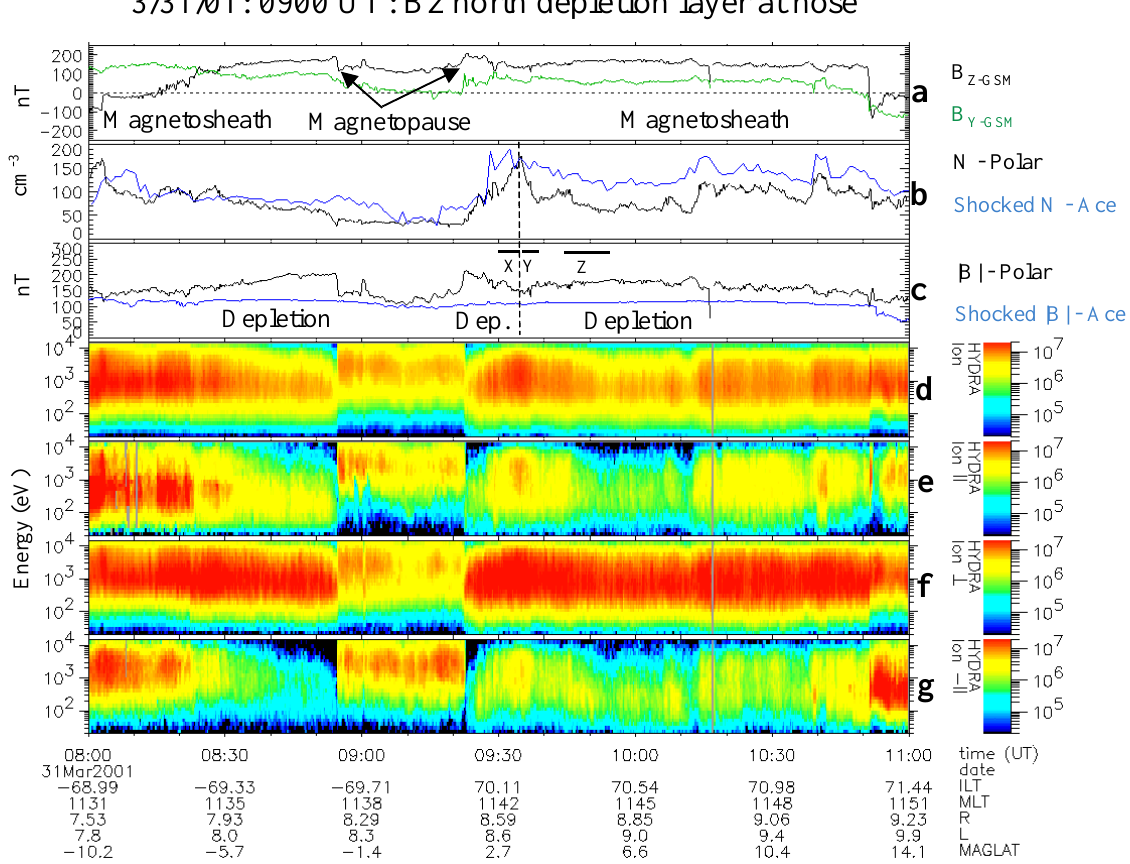
Fig. 1. Example from Polar of depletions layers with IMF B Z northward. Polar was located at 0 ◦ MLAT and 11:40 MLT. (a) The black trace is the measured B Z at Polar. The green trace is the measured B Y . The larger value of B Z just outside the magnetopause is a signature of a depletion layer. (b) The measured ion density at Polar (black) compared to the properly lagged (38min) ion density measured at ACE upstream in the solar wind (blue). Plasma densities attributed to ACE have been multiplied by a time-varying factor appropriate for density jumps predicted by the Rankine-Hugoniot relations for the subsolar bow shock and by an additional compression factor when Polar was close to the magnetopause as predicted by Spreiter and Stahara (1985). (c) The magnetic field magnitude measured at Polar (black) and at ACE (blue). ACE magnetic field measurements were multiplied by the time-varying Rankine-Hugoniot factor appropriate for the magnetic field jumps at the subsolar bow shock. (d–g) Ion energy spectrograms showing the total, parallel (pitch angles 0–30 ◦ ), perpendicular (75– 105 ◦ ) and antiparallel (150–180 ◦ ) ion fluxes ( (cm 2 − s − sr − 1E/E) − 1 ). Three intervals noted by X, Y, and Z indicate the data on which the regression analyses of Fig. 11 were